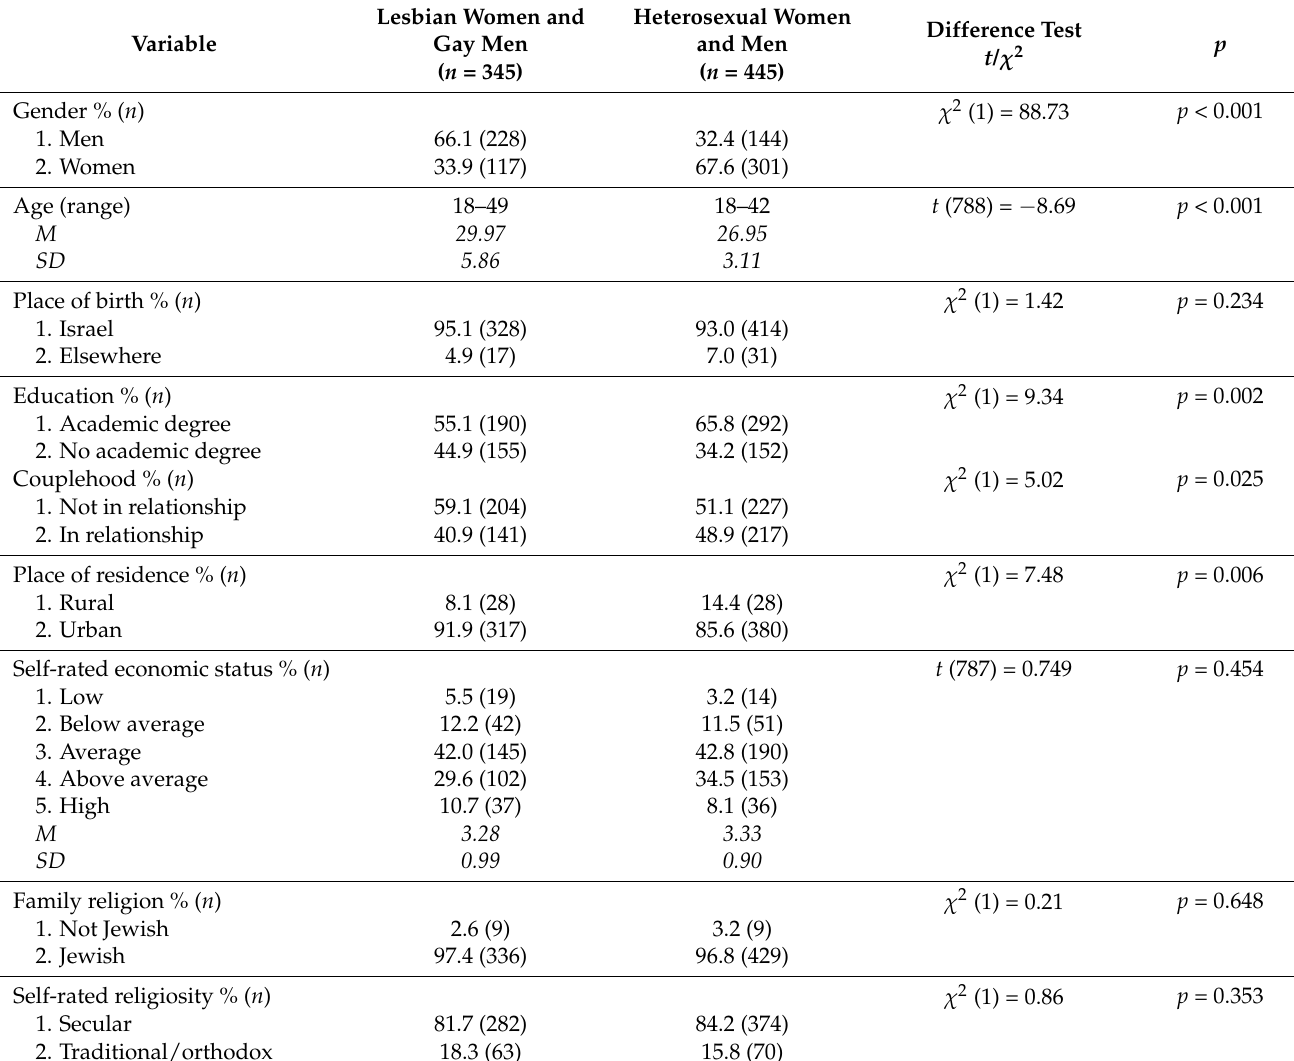
Table 1. Sociodemographic characteristics of the study